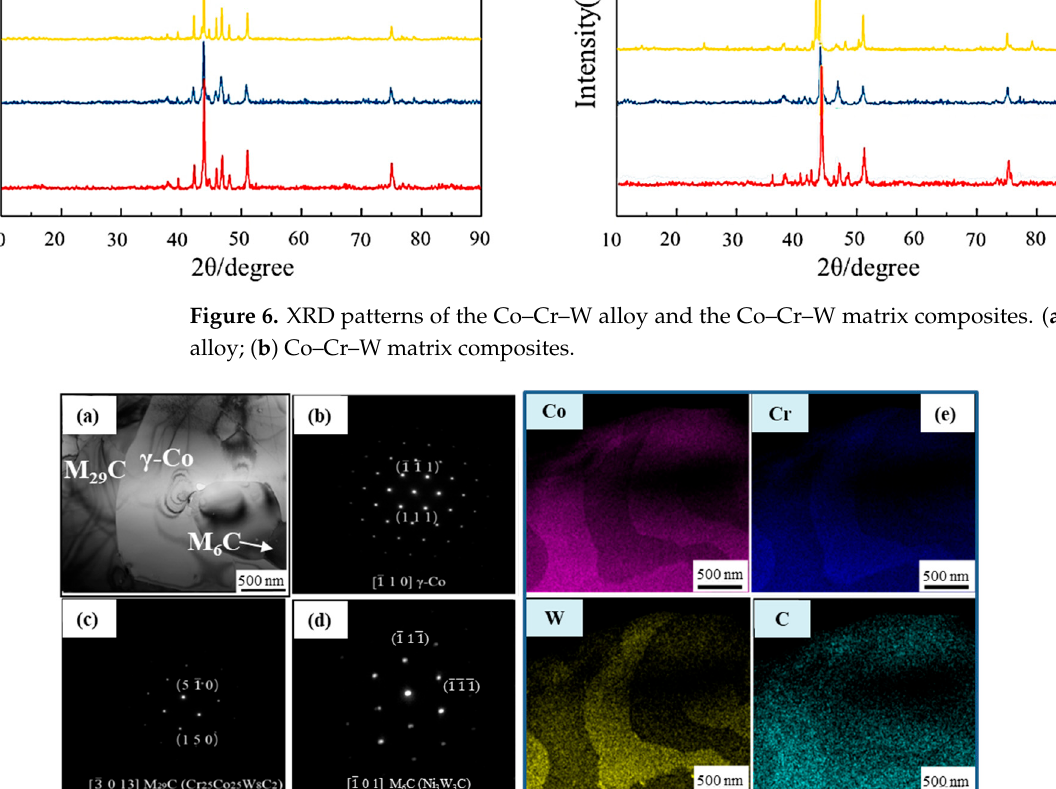
Figure 8. ( a ) HAADF images showing the precipitates in the Co–Cr–W matrix composites; ( b ) dis- playing the related EDS mapping results; ( c ) high-resolution electron image of the γ -Co phase; ( d , e ) bright-field image showing the precipitates in the Co–Cr–W matrix composites; ( f – i ) SAED patterns of the related phases.